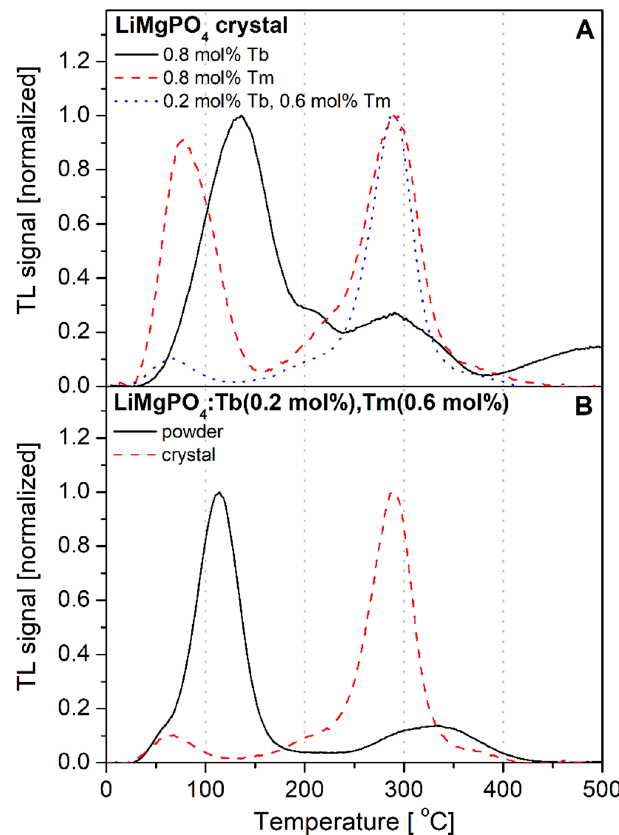
Figure 5. Panel ( A ): comparison of the glow-curves shape for the studied LiMgPO 4 crystals doped with Tb (solid line), Tm (dashed line), and both Tb and Tm simultaneously (dotted line). Panel ( B ): comparison of the glow-curves shape for LiMgPO 4 :Tb(0.2),Tm(0.6) powder (solid line) and crystal (dashed line). All the glow-curves were measured after the samples’ irradiation with beta radiation.